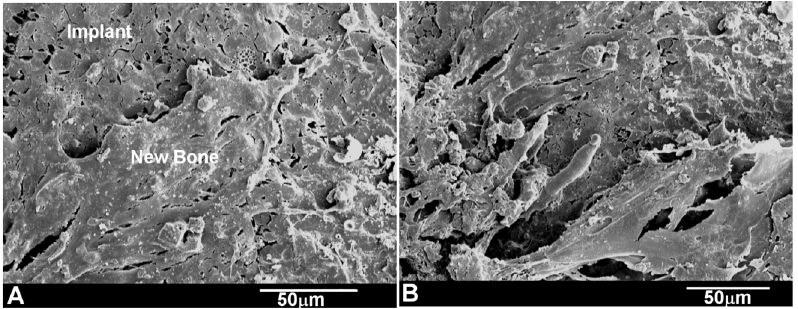
Figure 6. SEM images of the Bioeutectic implant after ( A ) four months of implantation showing the implant surface partially covered by an immature bone tissue; ( B ) at 15 months of implantation showing the whole surface of the implant covered by a newly formed bone tissue.